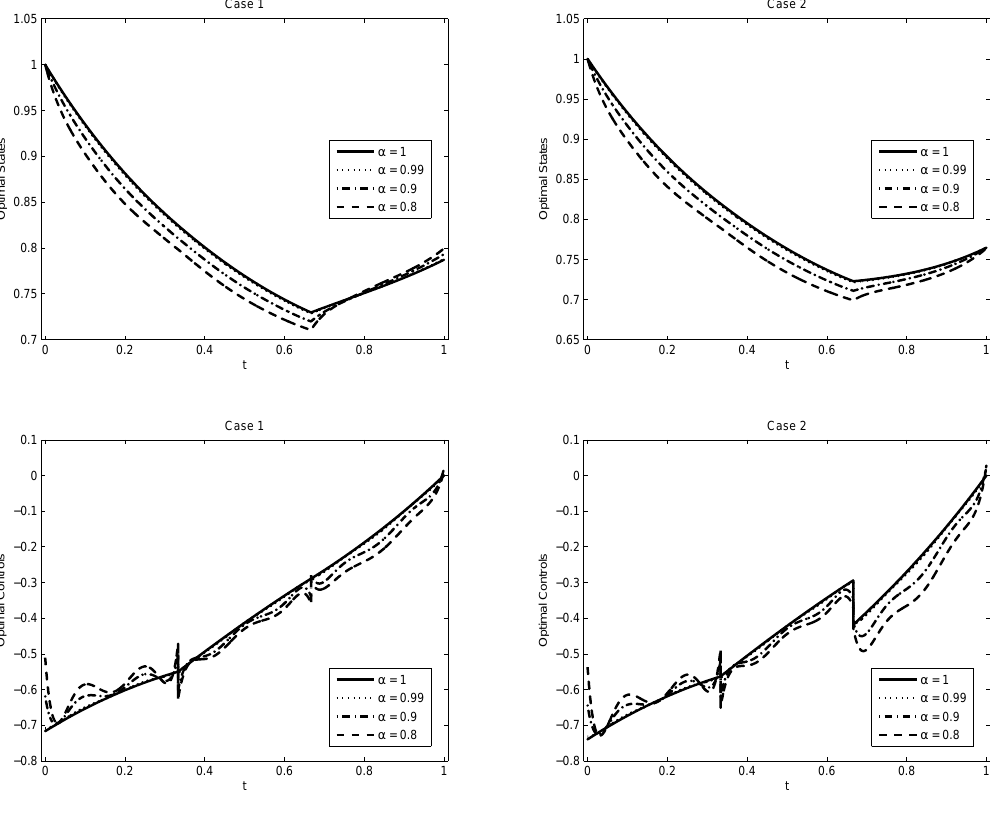
Figure 1. Optimal states and controls for Cases 1 and 2, Example 1. Table 3. Numerical results for Cases 1 and 2, Example